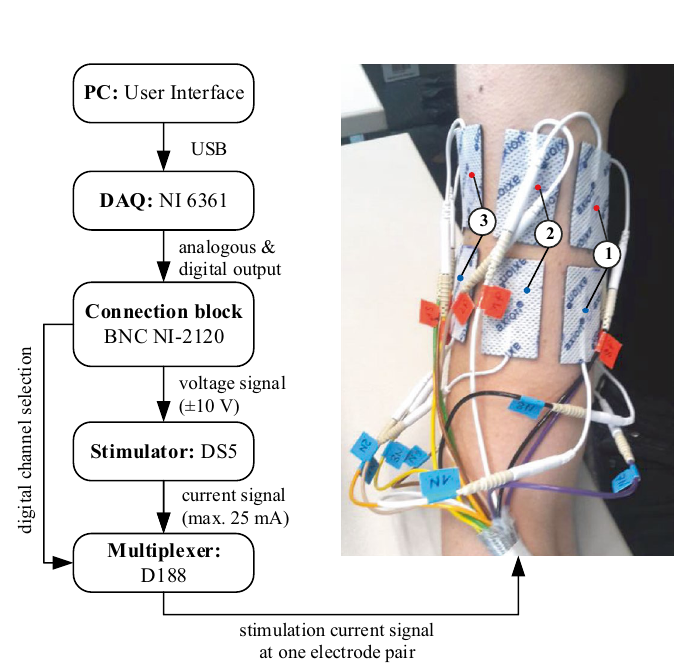
Table 1. Descriptive statistics of the study group.